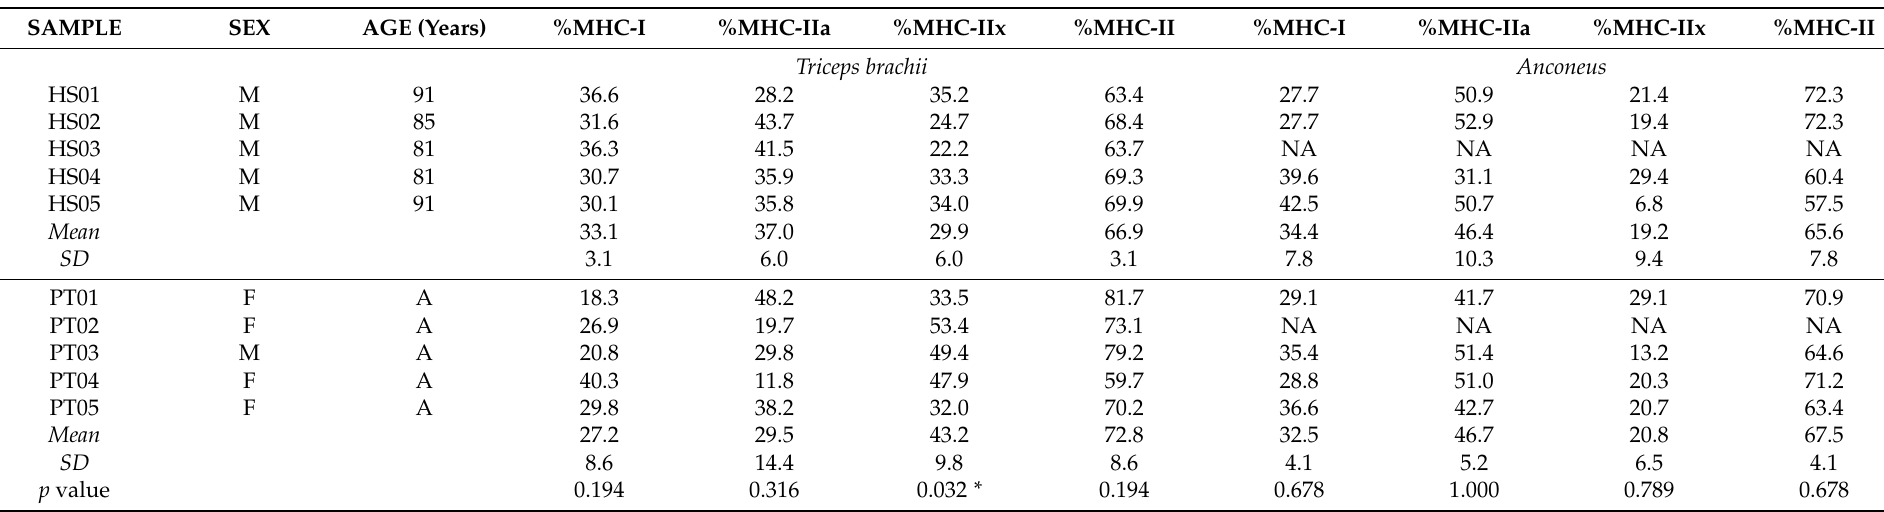
Table 2. Main findings on the expression of the MHC isoforms. MHC = myosin heavy chain; HS = Homo sapiens ; PT = Pan troglodytes ; M = male; F =